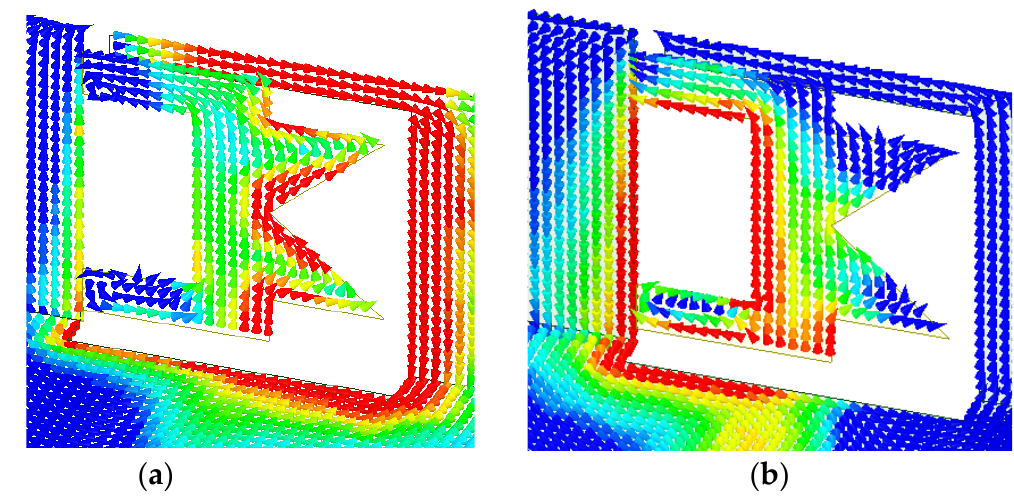
Figure 3. Simulated surface current distribution at ( a ) 3.4 GHz; ( b ) 4.9 GHz.